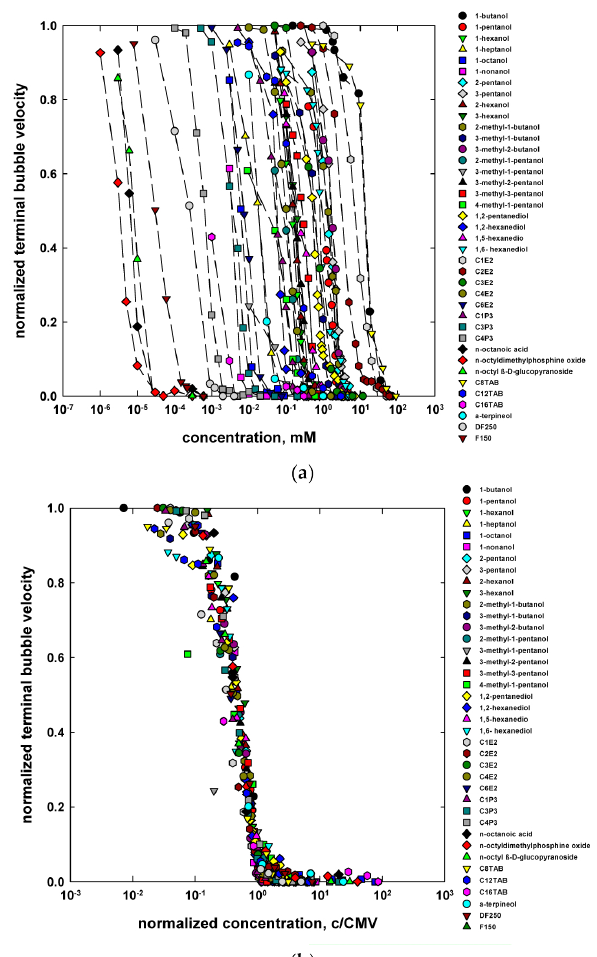
Figure 4. Influence of surfactant concentration expressed in mM ( a ) and normalized surfactant concentration ( c /CMV) ( b ) on the normalized terminal bubble velocity ( v − v min )/( v max − v min ).